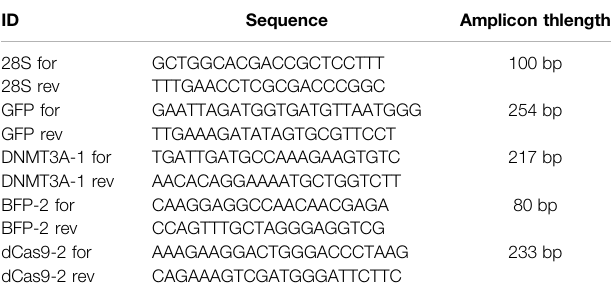
TABLE 3 | Primers designed to check for plasmid gene